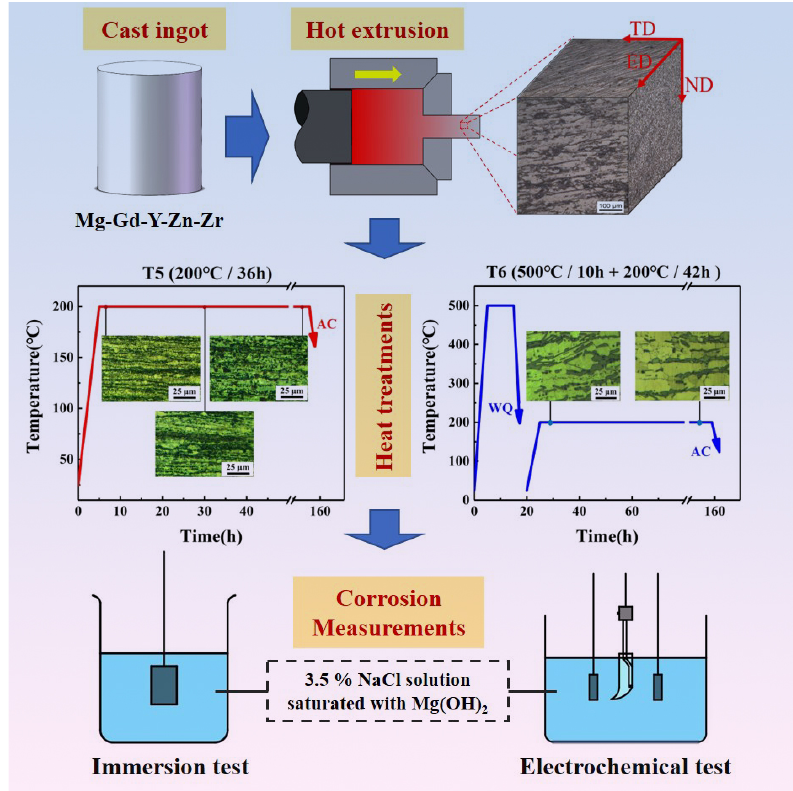
Figure 1. The overall experimental process and the initial microstructure of the studied